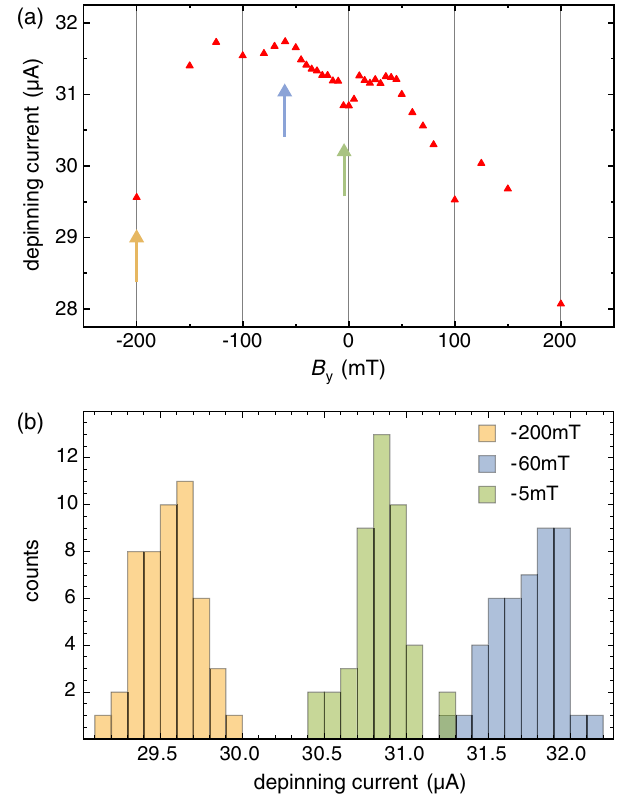
FIG. 3. dc transport signature of the field-enhanced pinning. (a) Depinning current as a function of the in-plane magnetic field component perpendicular to the current ( B ), measured for y ¼ 5 mT. Each data point is obtained from the average of B z 45 repeated IV measurements. (b) Histograms showing the distribution of the depinning current values for three selected values of B , namely, − 5 mT (light green), − 60 mT (light blue), y and − 200 mT (light orange). These values are indicated by arrows of the corresponding colors in the top